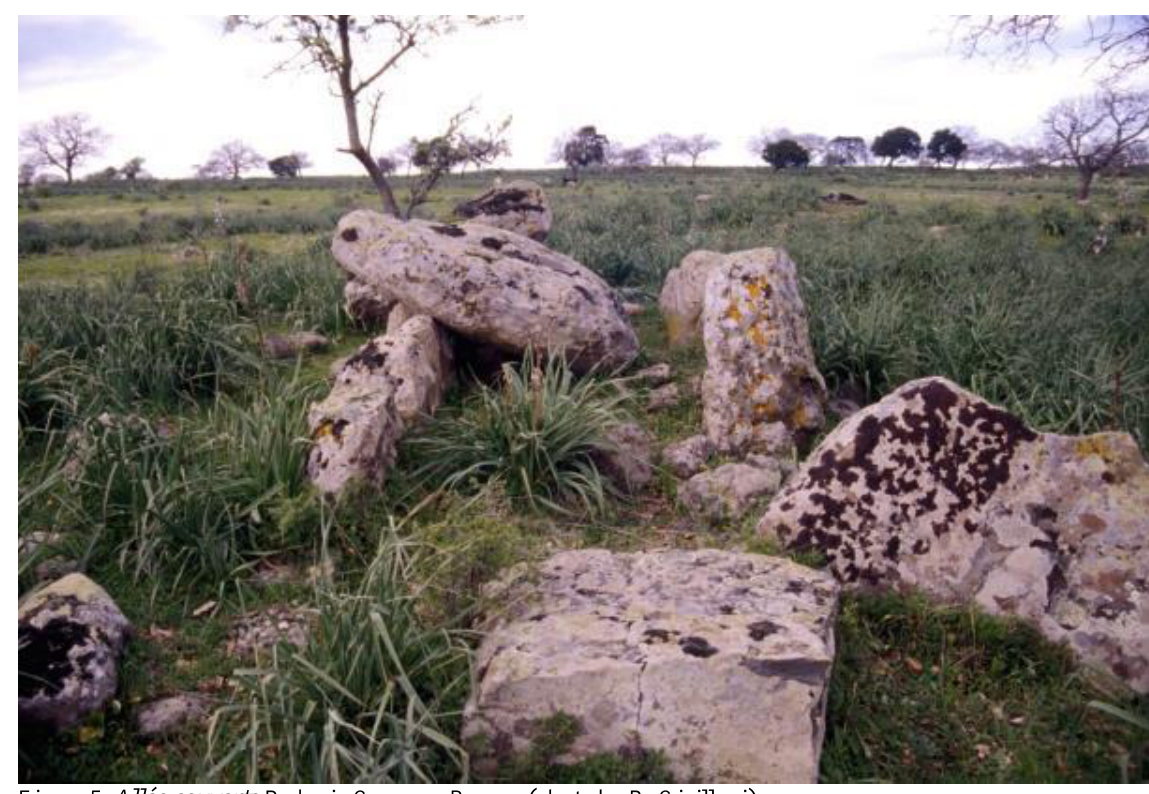
Figure 5. Allée couverte Pedra in Cuccuru, Borore (photo by R.